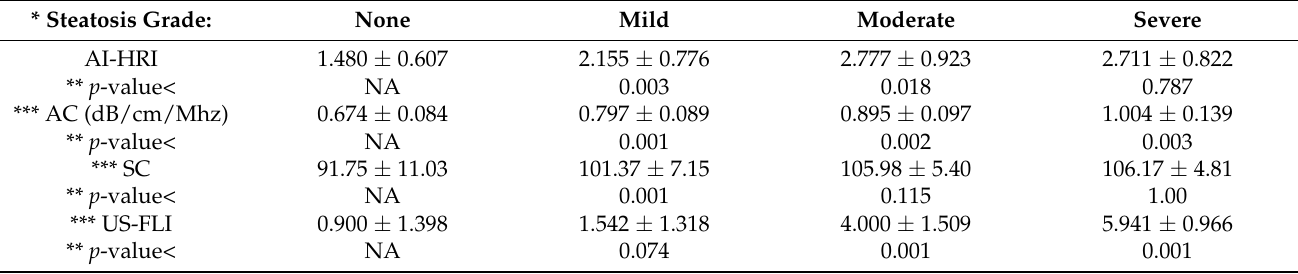
Figure 3. Box plots show the distribution of ( A ) artificial intelligence-calculated hepatorenal index (AI-HRI) values and ( B ) ultrasonographic fatty liver indicator (US-FLI) scores in increasing grades of hepatic steatosis. Magnetic resonance imaging proton density fat fraction (MRI-PDFF) was used as the reference method. We compared AI-HRI and US-FLI between different steatosis grades with the pairwise Wilcoxon rank sum test and labeled significant differences with the p -value. Table 2. Values measured with QUS methods in increasing grades of hepatic steatosis.